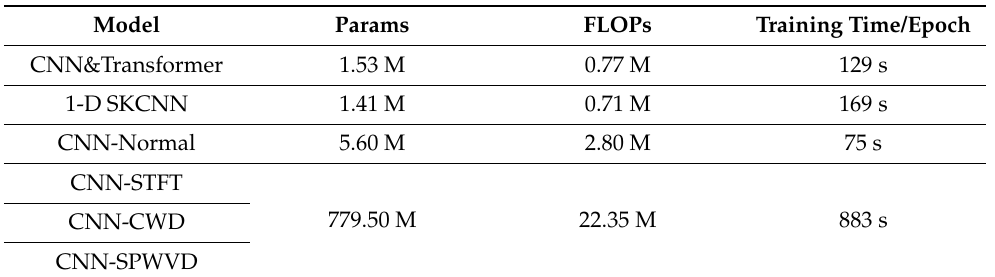
Table 8. The parameters, floating point operations and the training time per epoch of the mentioned